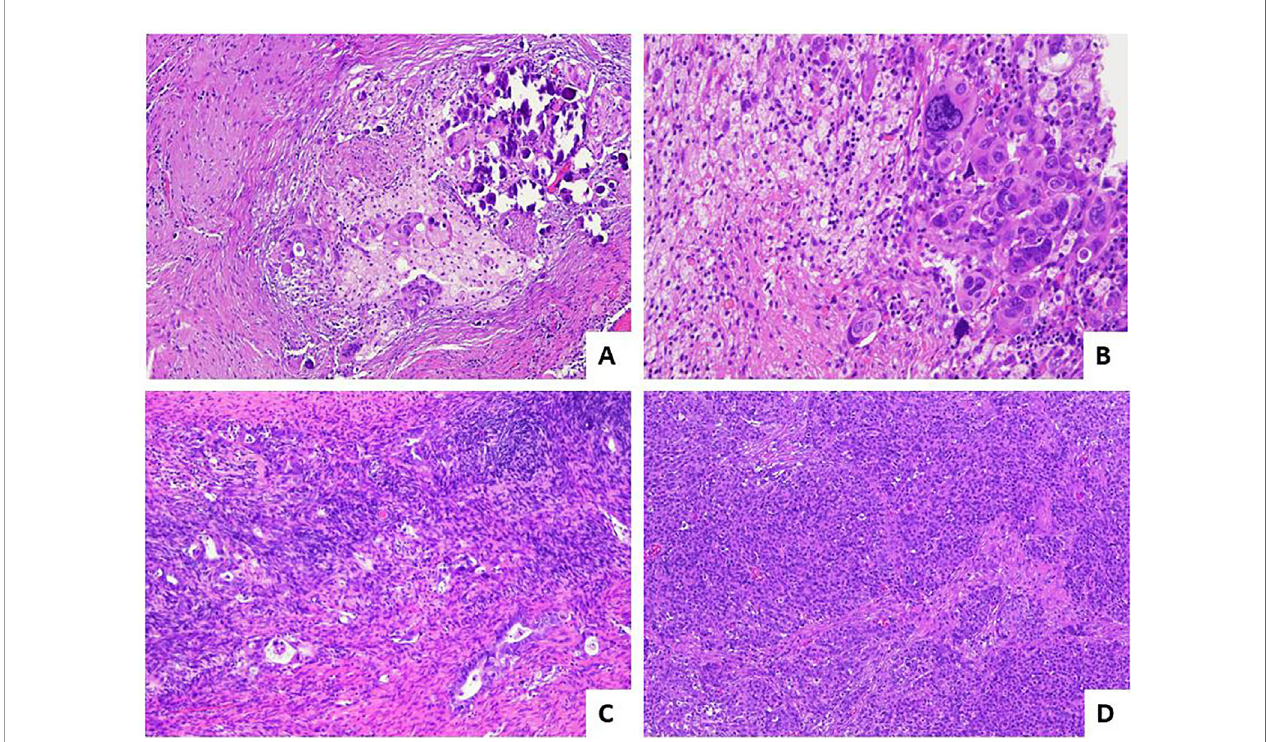
FIGURE 1 | Pathological response score for post-NACT high-grade serous tubo-ovarian carcinoma. (A) Example of CRS3 score: diffuse regressive fi bro-in fl ammatory changes with small residual foci of neoplasms <2 mm [hematoxylin and eosin-stained sections (H&E); 10×]. (B) Higher magni fi cation of image in A, with evidence of residual marked atypical neoplastic cells.(H&E; 40×). (C) Example of CRS2 score with appreciable response: residual tumor easily identi fi able, >2 mm, with diffuse regression-associated fi bro-in fl ammatory changes (H&E; 10×). (D) Example of CRS1 score with absent response: tumor without evidence of regression (H&E;